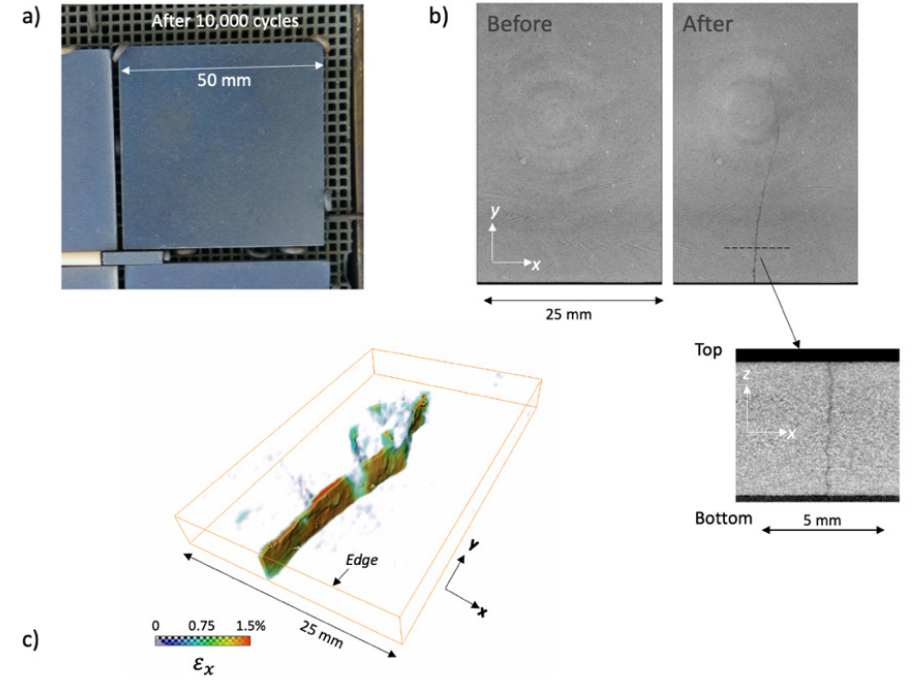
Figure 5. I ndustrial tomography (Gilardoni): ( a ) specimen (slab 23) within the tomography system; ( b ) 3D visualization within the full slab of crack, which propagates from the middle of the left edge towards the center. All images show the full 50 mm × 50 mm slab.